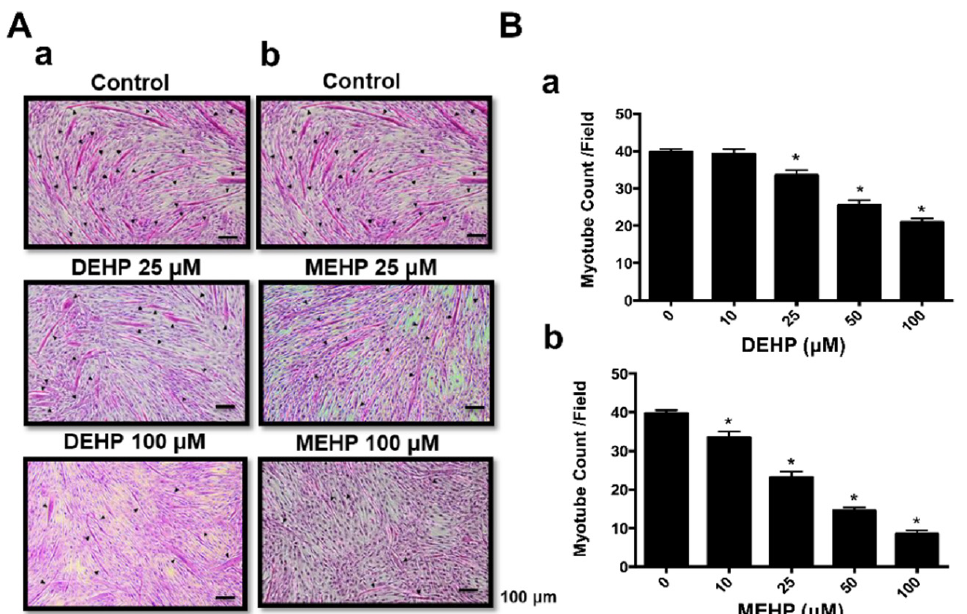
Figure 3. The changes in myotube formation in C2C12 myoblasts treated with both DEHP and MEHP. Under differentiation medium, C2C12 cells treated with DEHP ( Aa , Ba ) or MEHP ( Ab , Bb ) (10–100 µ M) for 96 h were observed. The cell morphology ( A ) was shown and myotube formation ( B ) was counted. Data are presented as means ± SEM (three independent experiments, triplicate repeats in each); p < 0.05 indicates significance compared to the control (*).